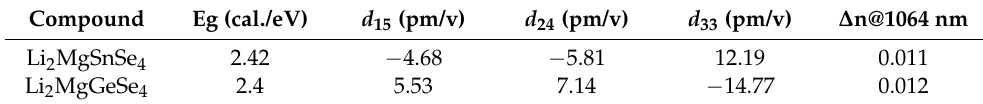
Table 2. Calculated band gaps, SHG coefficients and birefringence of Li 2 MgSnSe 4 and Li 2 MgGeSe 4 . Compound